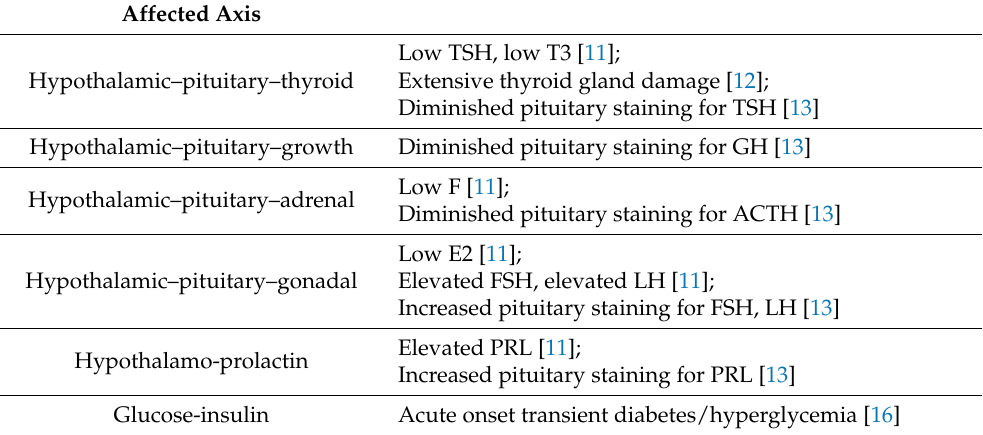
Table 1. Summary of endocrine aspects of patients with